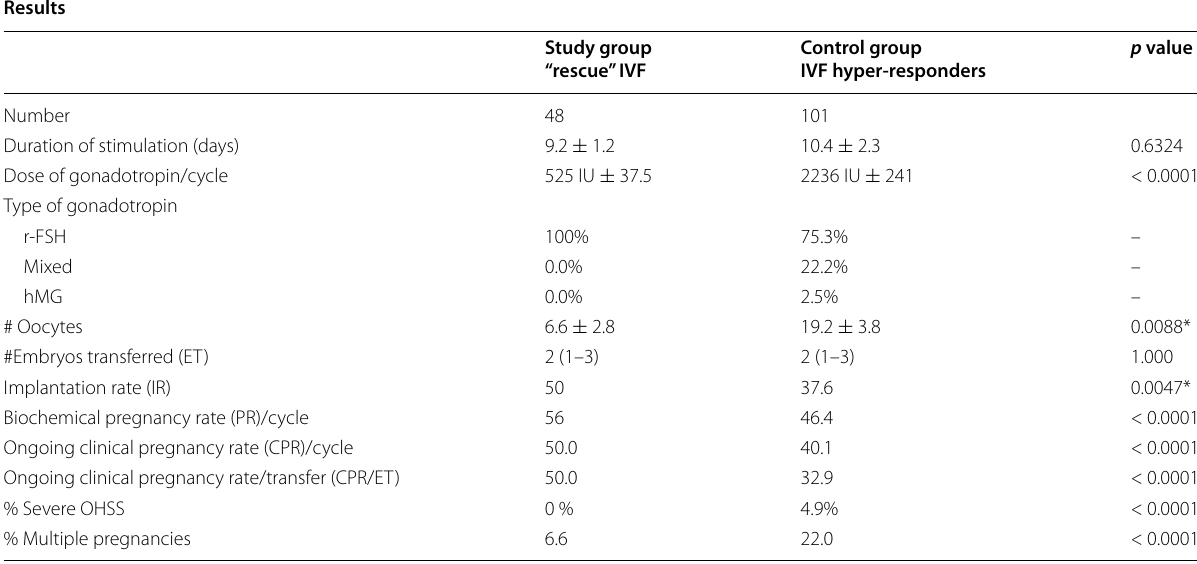
Table 5 The pregnancy outcome between hyper responder rescue IVF and control group IVF hyper